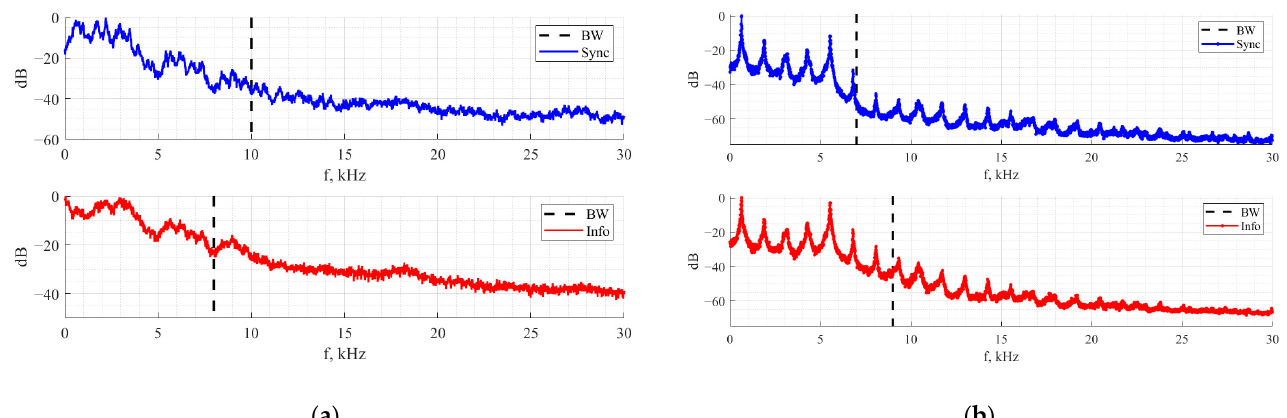
Figure 13. Vilnius oscillator synchronization signal spectra (blue) and information-carrying signal spectra (red) ( a ). Chua’s oscillator synchronization signal spectra (blue) and information-carrying signal spectra (red) ( b ).